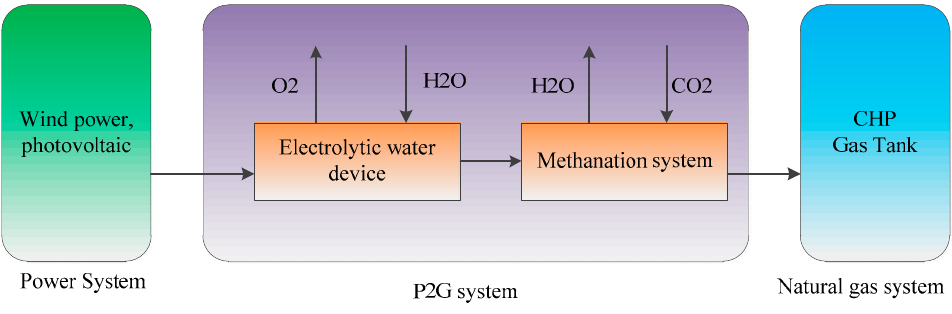
Figure 2. Schematic diagram of the P2G technology.